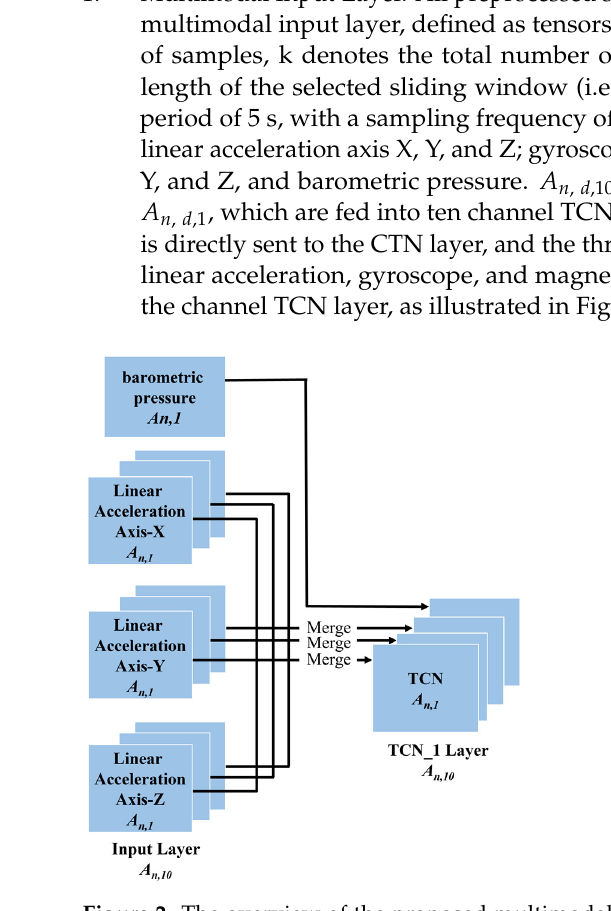
Figure 1. The schema of the overall overview of our proposed T2Trans model. Preprocessed sensor data are fed into the model from the multimodal input layer, which are fed into ten channel TCN